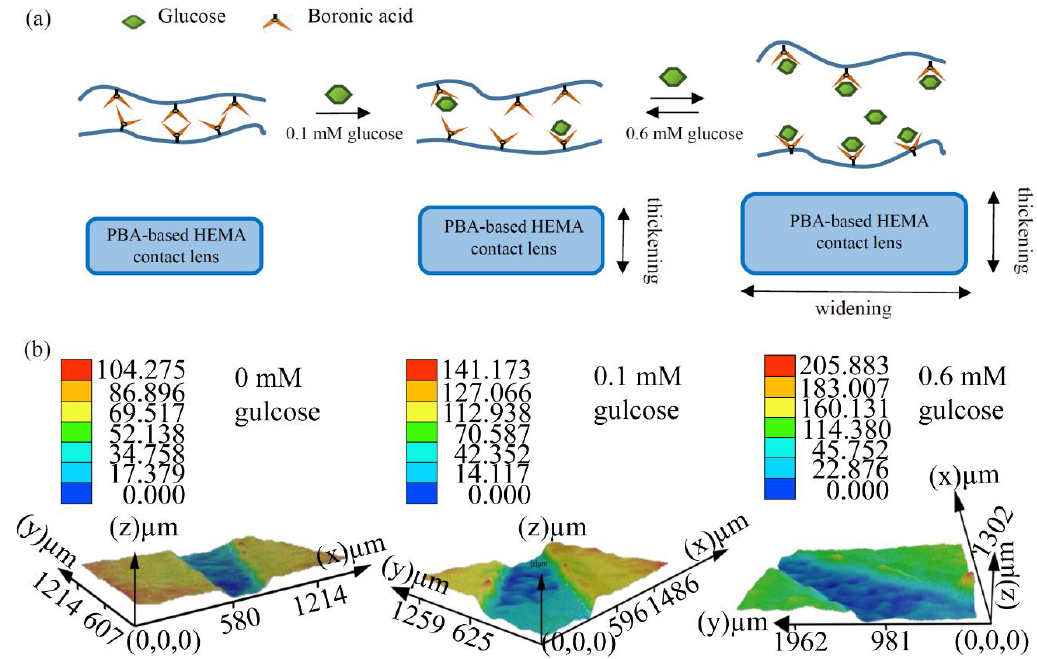
Figure 3. Properties of the PBA-based HEMA contact lens at different glucose levels. ( a ) Schematic illustration of the PBA-based HEMA contact lens. Principle of glucose detection in different glucose concentrations (0, 0.1 and 0.6 mM). ( b ) PBA-based HEMA contact lens at different glucose levels as observed with a Leica DVM6 digital microscope. Different colors represent the distance in the z -axis between the underside and surface of the contact lens.